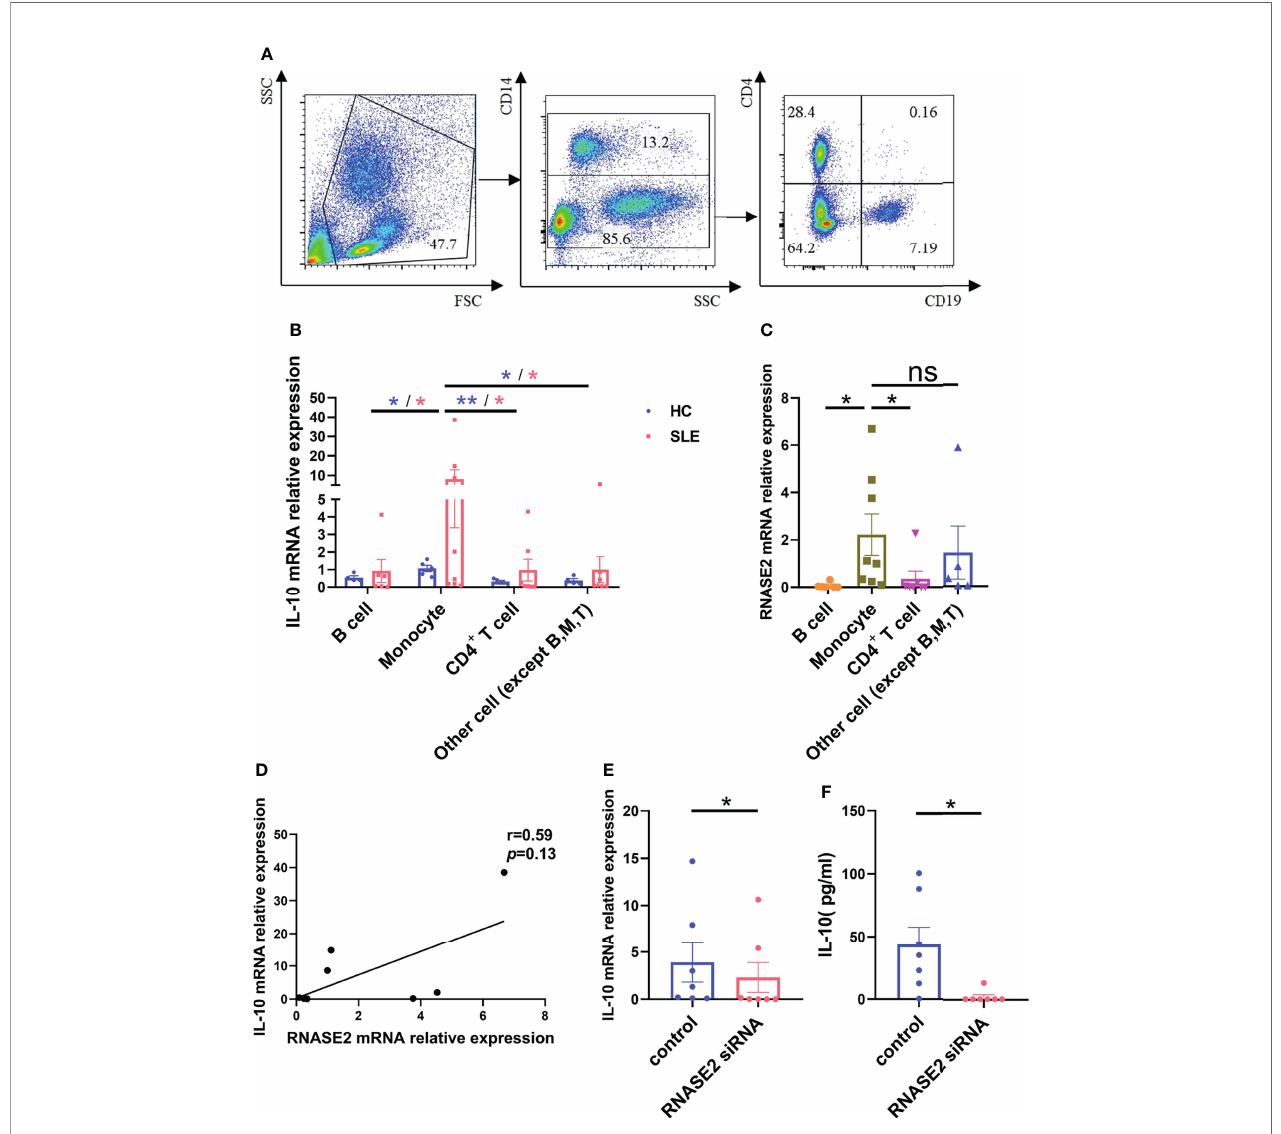
FIGURE 5 | RNASE2 promoted the secretion of IL-10 from lupus monocytes. (A) Flow cytometry sorting technology was used to separate lupus CD14 + monocytes, CD19 + B cells, CD4 + T cells and the remaining CD14 - CD19 - CD4 - cells. (B) mRNA expression of IL-10 in each cell subgroup was detected by real-time PCR, and the highest expression was seen in monocyte subgroup (n=5), especially those from SLE patients (n=8). (C, D) mRNA expression of RNASE2 was also prominent in monocyte subgroup from lupus patients, which was correlated with monocyte IL-10 mRNA level (by Spearman correlation test, n=8). (E, F) RNASE2 silencing down-regulated IL-10 mRNA expression in lupus monocytes and IL-10 protein levels in cultured supernatants (n=7). Data are presented as mean ± SEM, *p < 0.05, **p < 0.01, ns, no signi fi cant statistical